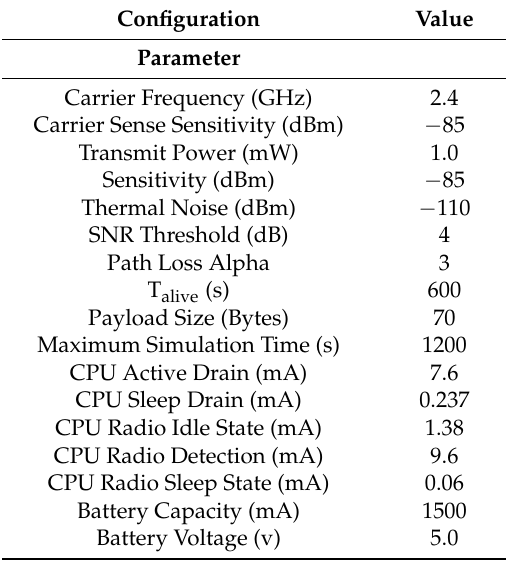
Table 1. Main configuration parameters for the battery module, PHY, MAC and APL